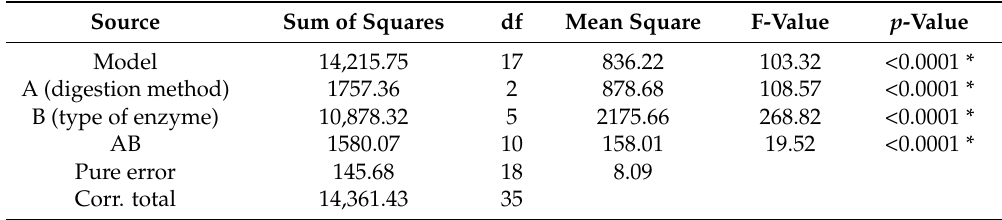
Table 2. ANOVA of effects of digestion method and applied enzyme (* p -values less than 0.05 indicate that model terms are significant).